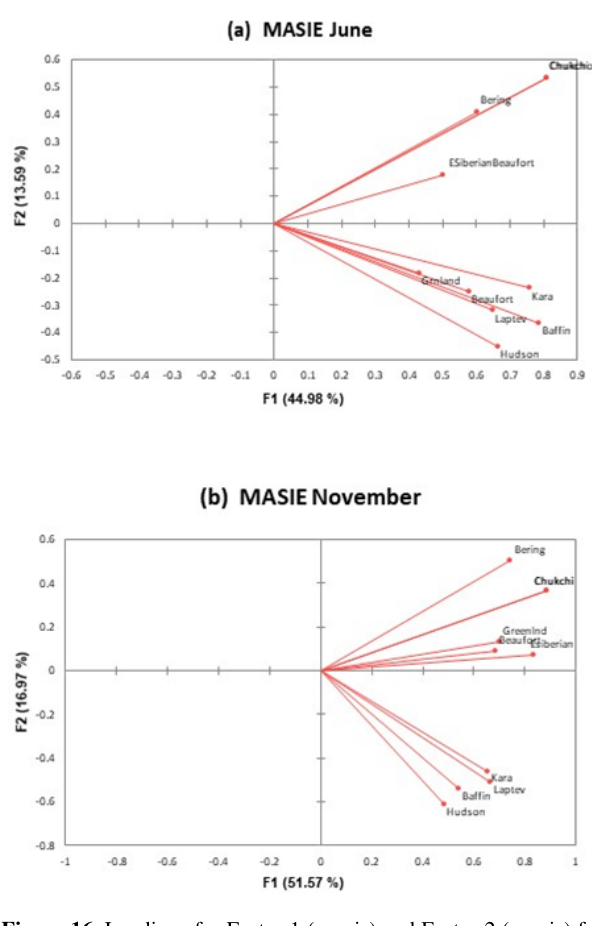
Figure 16. Loadings for Factor 1 ( x axis) and Factor 2 ( y axis) for the MASIE regional ice areas of (a) June and (b) November. Labels on vectors denote MASIE